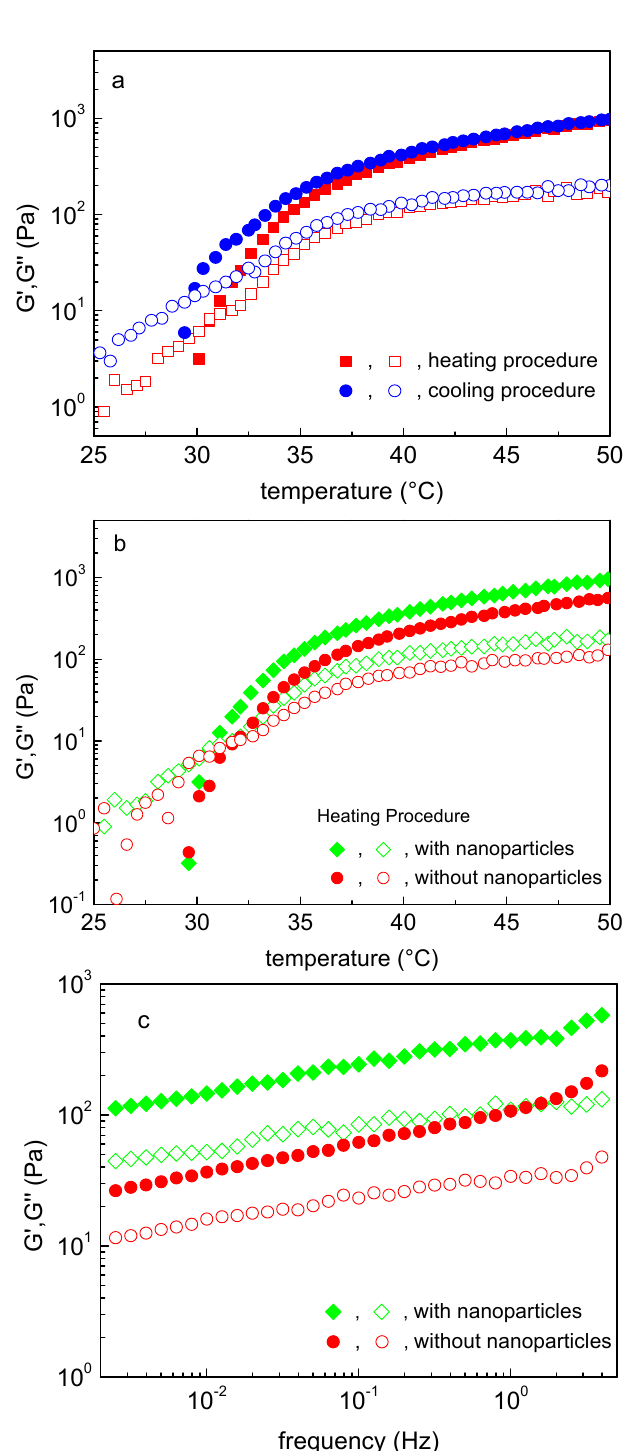
Figure 6. Temperature dependence of storage modulus G’ (solid symbols) and loss modulus G” (open symbols) ( a ) heating/cooling cycle of 5 wt% NaALG-g graft copolymer aqueous solution with hNP, ( b ) at heating procedure at of 5 wt% polymer aqueous solutions with hNP (rhombus, green) and without (circle, red). The heating/cooling procedures were performed at 1 Hz and strain amplitude of 0.1% at a rate of 1 °C/min. ( c ) Frequency sweep at 37 °C of storage G ′ (closed symbols) and loss G ″ (open symbols) moduli of 5 wt% NaALG-g aqueous solutions with hNP (rhombus, green) and without hNP (circle, red).